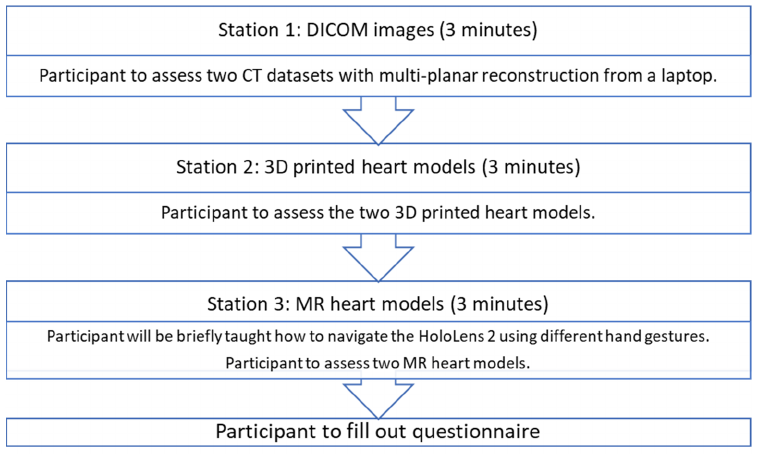
Figure 5. The process each participant undertook.